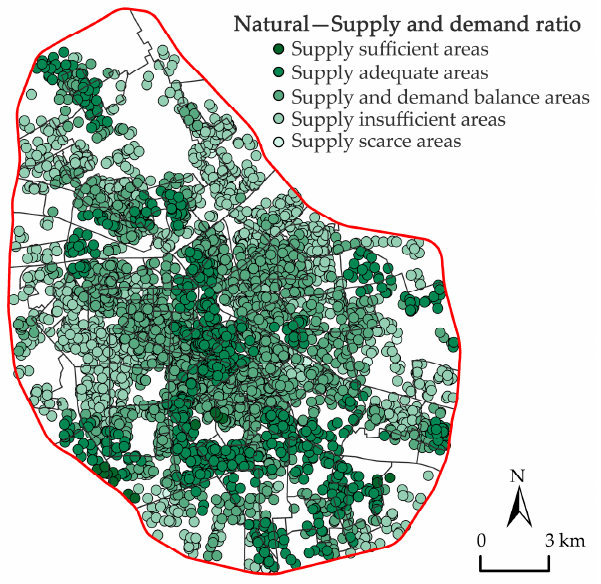
Figure 8. Schematic diagram of SDM assessment of public natural health resources in the research area. Table 5. Hierarchical statistics of SDM of public natural health resources in central Tianjin.